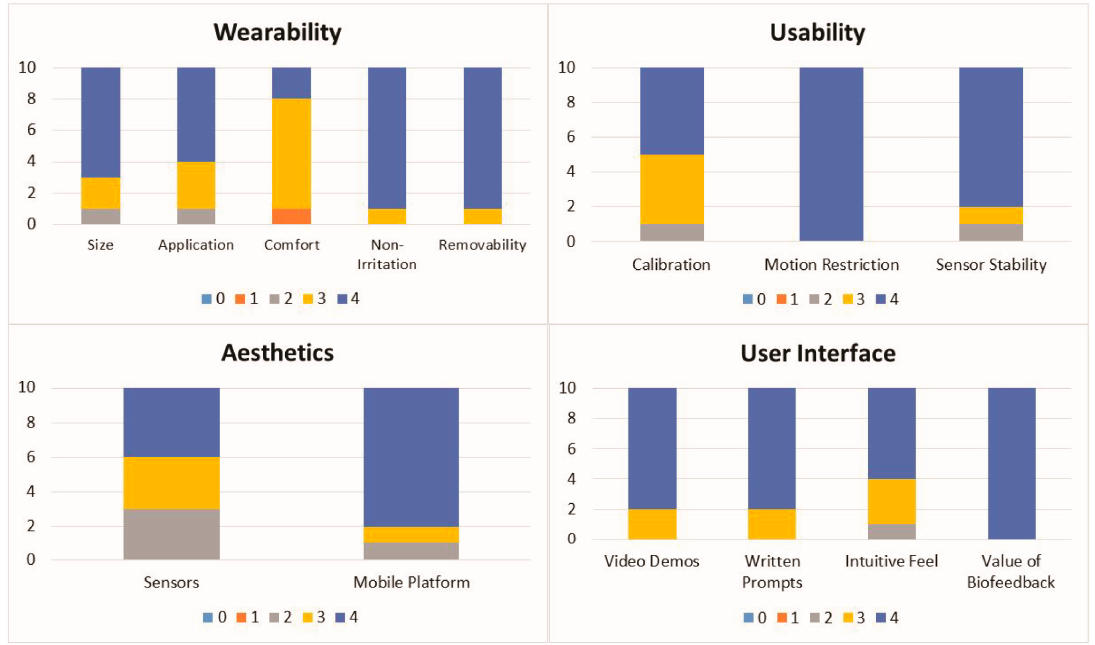
Figure 4. Frequency bar graphs of the custom usability survey results.